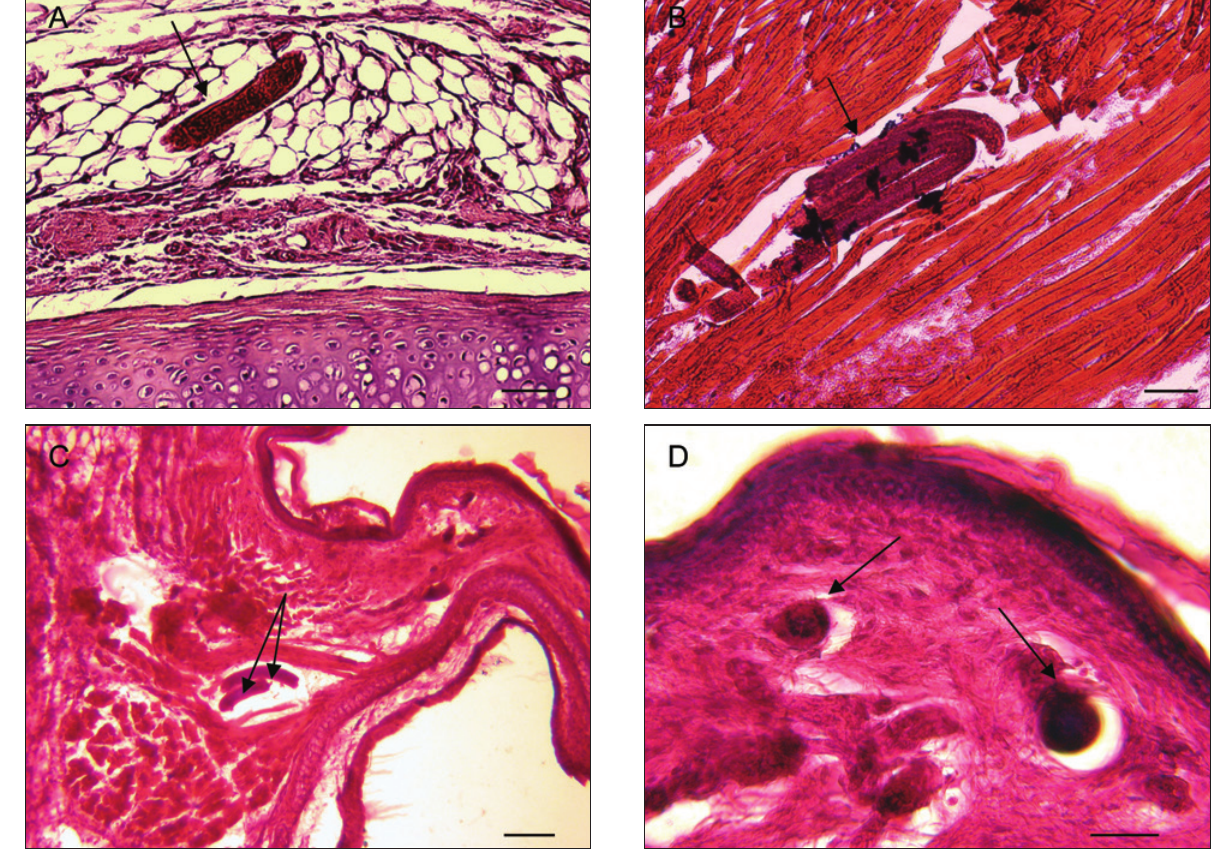
Fig. 4. – Trichosomoides nasalis (arrows) in tissues external to the nasal cavities. A, in the adipose tissue of the dorsal region of the muzzle. B & C, between muscle fibres of the nasal muzzle and vestibulum, respectively. D, in dermal connective tissue of the nasal vestibulum, two worms in transverse section. Scale bars in μ m: A, B, D, 50; C,